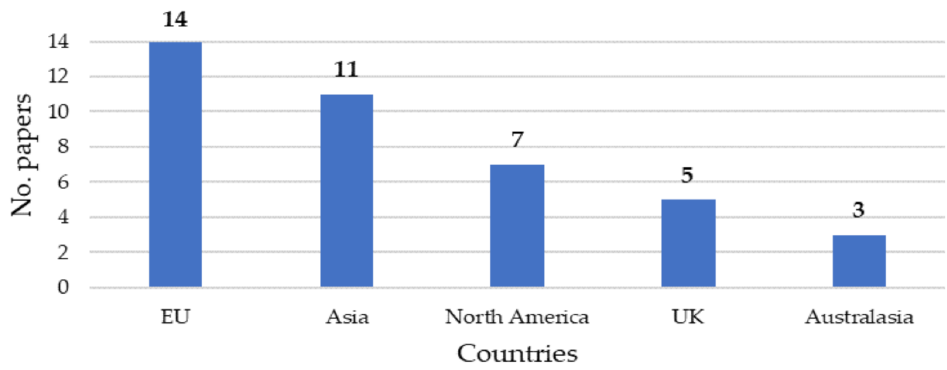
Figure 4. Distribution of papers by country areas.